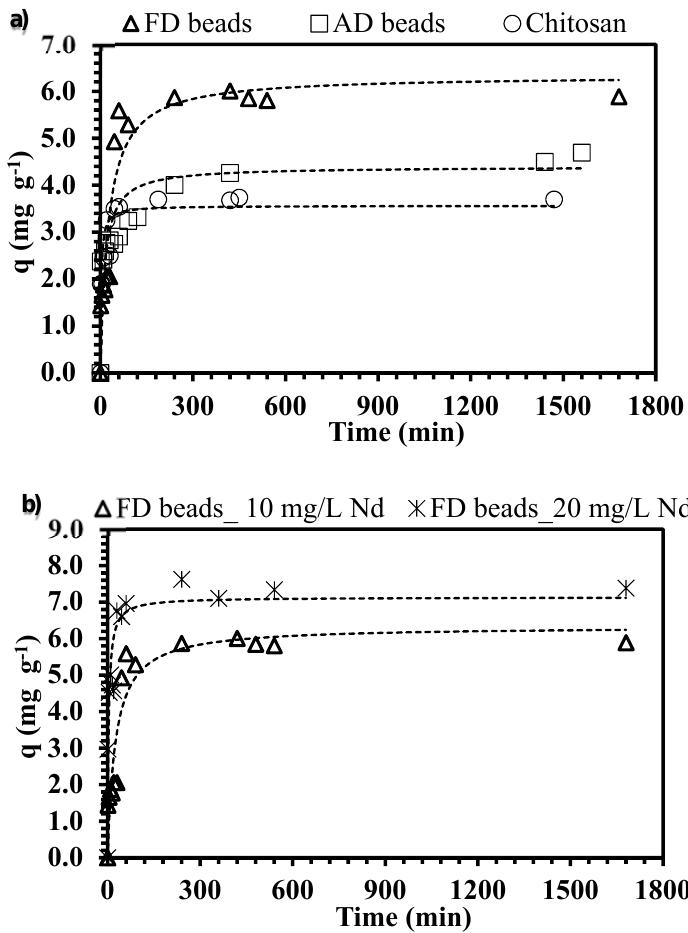
Figure 6. Effect of contact time on ChiFer(III) material performance. ( a ) Effect of drying method. ( b ) Effect of initial metal concentration. (Dashed line: Pseudo ‐ second order rate equation (PSORE); T: 20 °C; sorbent dosage, SD: 0.5 g L − 1 ; agitation speed: 150 rpm; contact time: 72 h; pH: 4; C 0 : 10–20 mg L − 1 ).